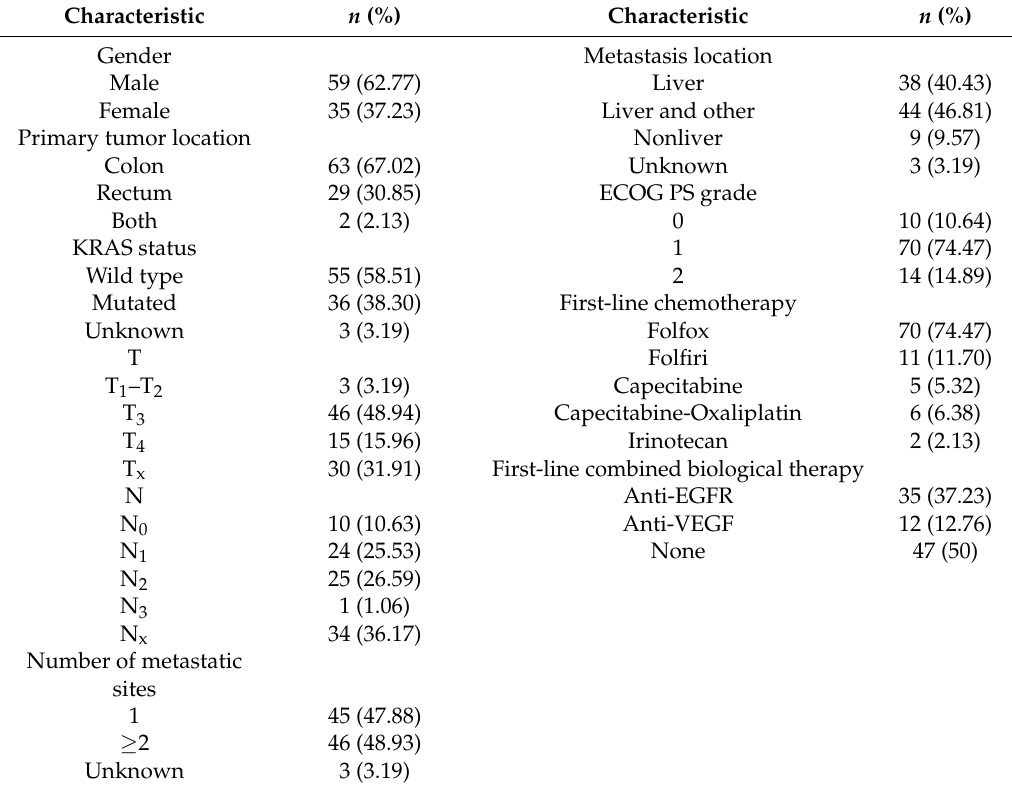
Table 4. Patient